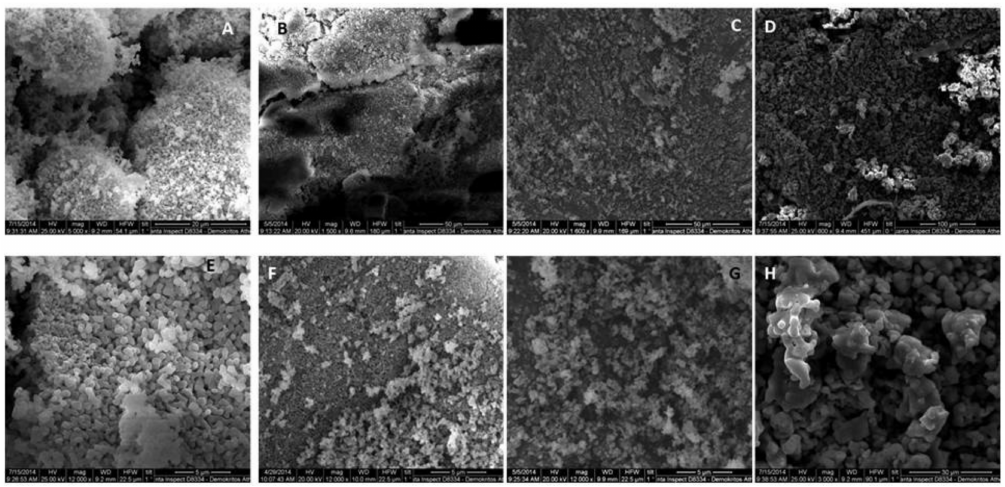
Figure 3. SEM photomicrographs of the 100% β -TCP ( A , E ), BCP (( B , F ) 13% HA—87% β -TCP; ( C , G ) 41% HA—59% β -TCP) and 100% HA ( D , H ). ( A – D ) Low magnification, ( E – H ) high